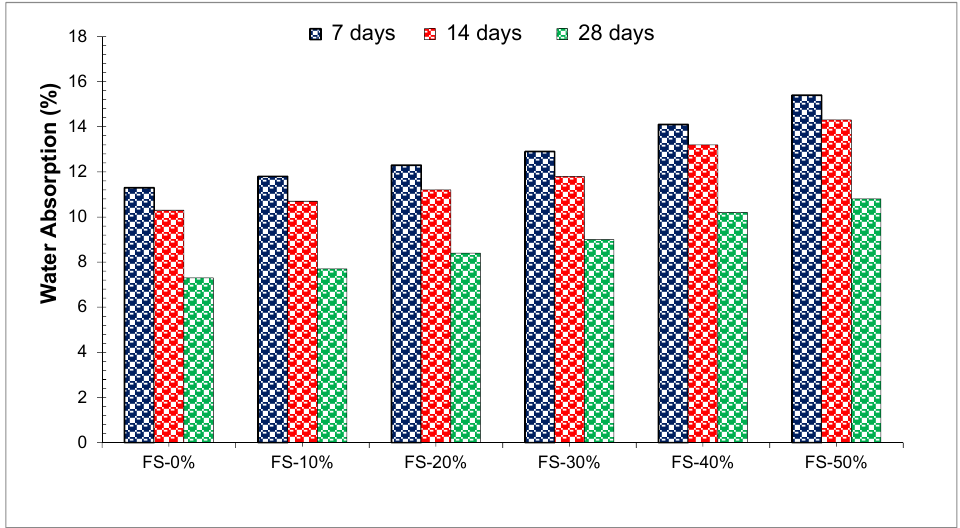
Figure 8. Water Absorption [39]. Figure 8.